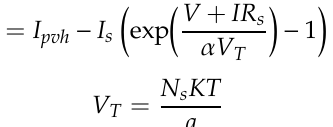
Table 1. Electrical parameters of the “Sunpreme SNPM-GX-315”.